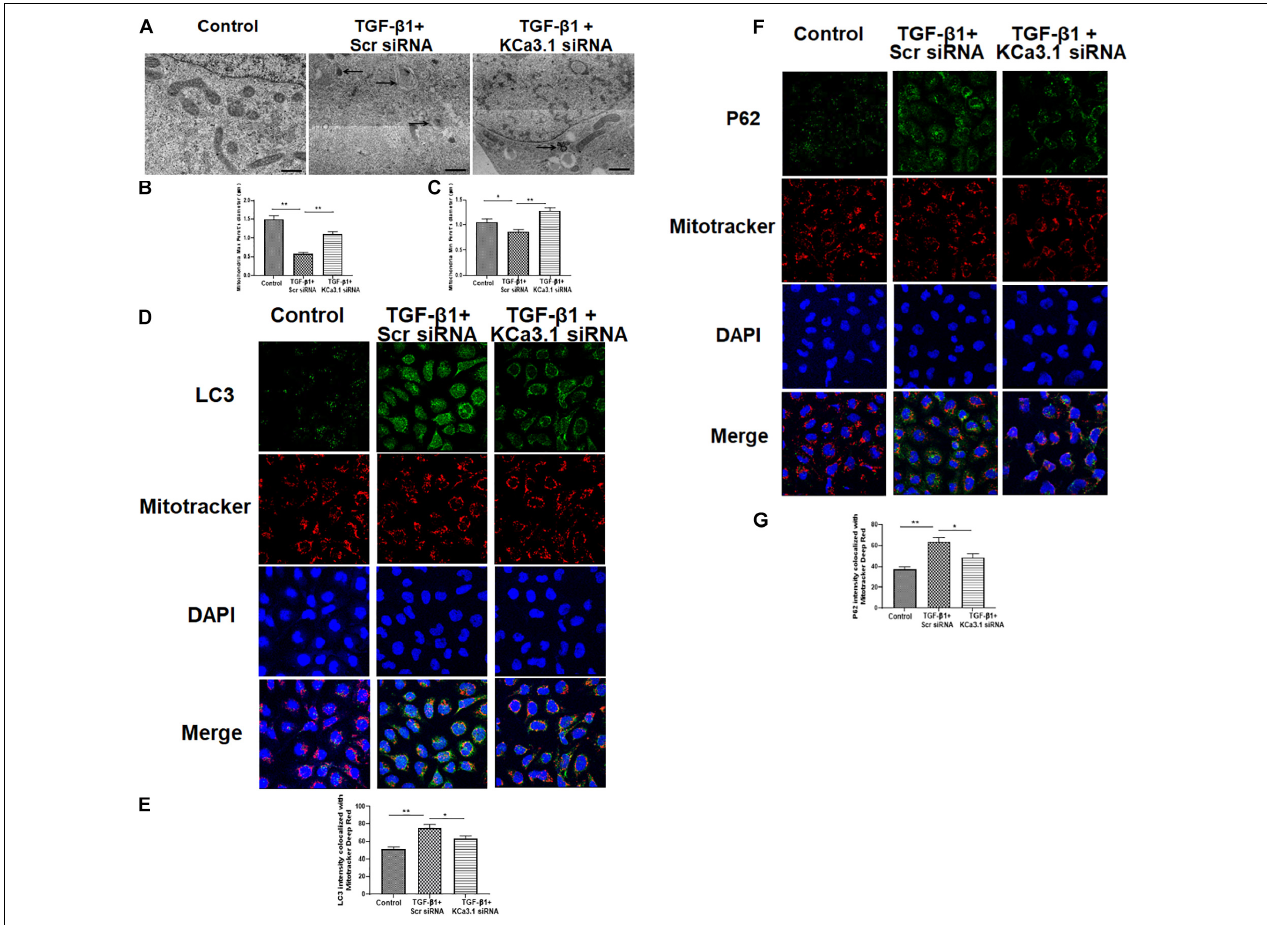
FIGURE 3 | KCa3.1 gene silencing reversed TGF- β 1-induced inhibition of mitophagy in HK2 cells. (A) Representative electron micrographs of mitochondrial morphology from HK2 cells. The arrow displays abnormalities in mitochondrial morphology indicative of mitophagy in the groups exposed to TGF- β 1. Quantification of maximum (B) and minimum (C) Feret’s diameter in HK2 cells. Scale bars, 200 nm. Confocal microscopy of MitoTracker Red-labeled mitochondria and LC3 staining (D) and P62 (F) . Quantification of fluorescence intensity of LC3 colocalized with mitochondria (E) and P62 colocalized with mitochondria (G) in HK2 cells. Results are presented as mean ± SEM. * P < 0.05, ** P < 0.01, N = 3. Original magnification: × 600.